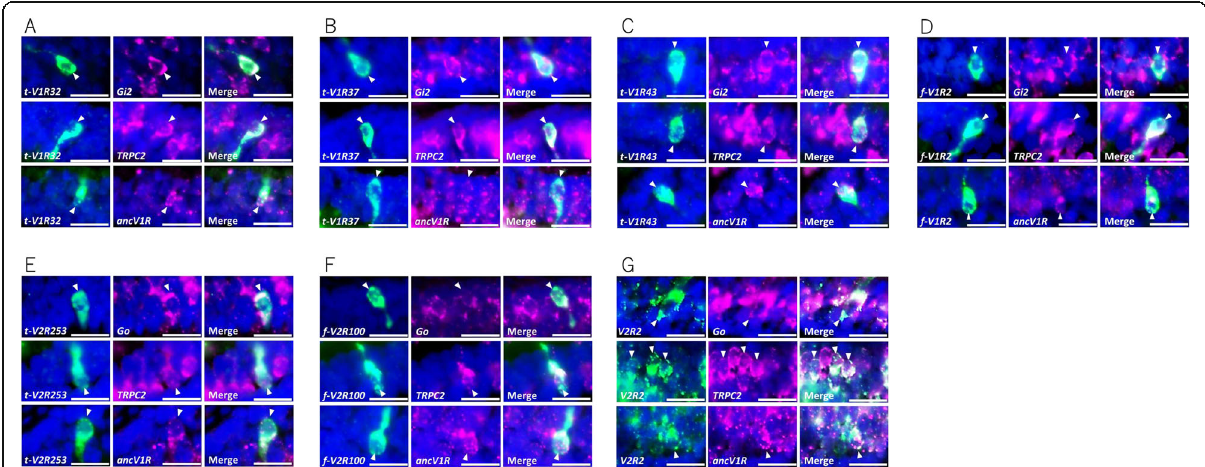
Fig. 5 Coexpression of V1R s and V2R s with VNO-related genes in the olfactory sensory neurons of bichir. ( A - D ) Coexpression of ( A ) t- V1R32 , ( B ) t- V1R37 , ( C ) t- V1R43 , and ( D ) f- V1R2 (green) with VNO-related genes ( Gi 2 , TRPC2 , and ancV1R ) (magenta). ( E - G ) Coexpression of ( E ) t- V2R , (F) f- V2R , and ( G ) V2R2 (green) with VNO-related genes ( Go , TRPC2 , and ancV1R ) (magenta). Arrowheads indicate the coexpressing cells. The cell nuclei were stained by DAPI (blue). All scale bars indicate 20 μ m